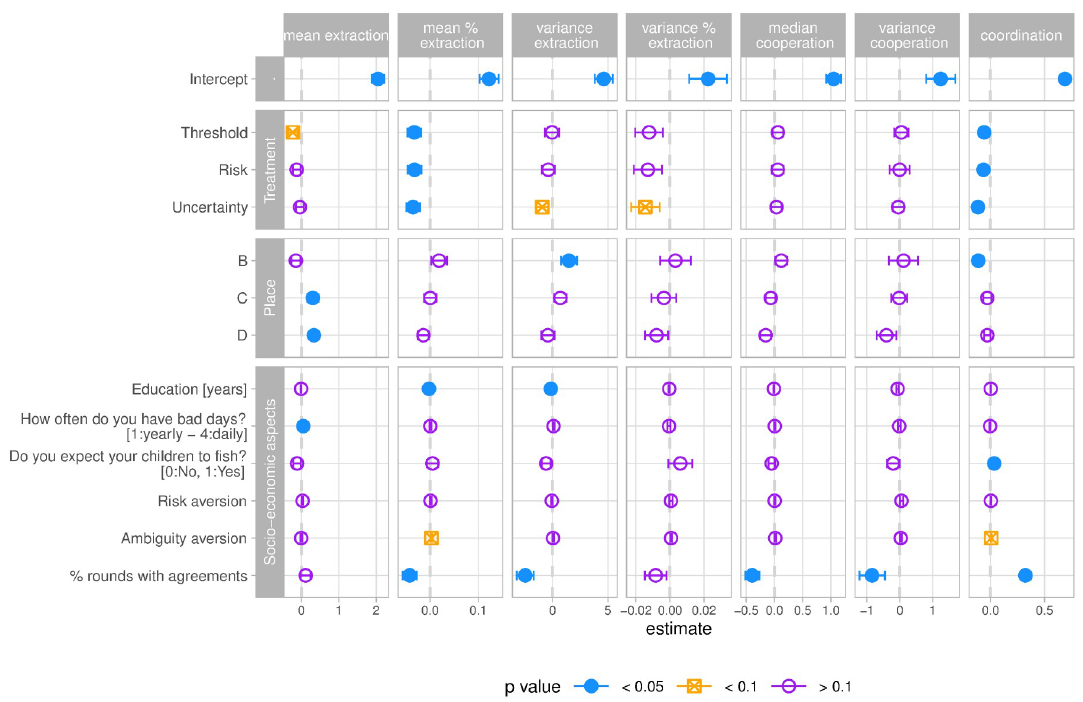
Fig 4. Individual behaviour as function of treatments and different contextual factors. The panel summarises results from an OLS regression for each of the response variables. Treatment effects are shown by taking into account place (A-D), group dynamics (e.g. reaching agreements), and several socioeconomic aspects. S4 Table in S1 File complement this figure with precise estimates and summary statistics. Error bars denote 95% confidence intervals calculated with a CR2 robust standard errors estimator.